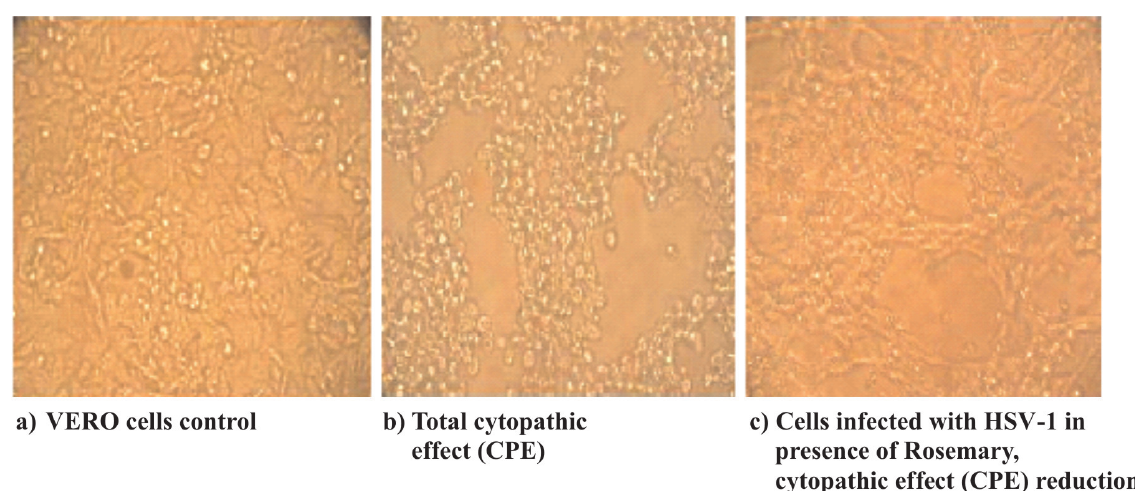
FIgURE 2 – The HSV-1 cytopathic effect and its inhibition by the antioxidant